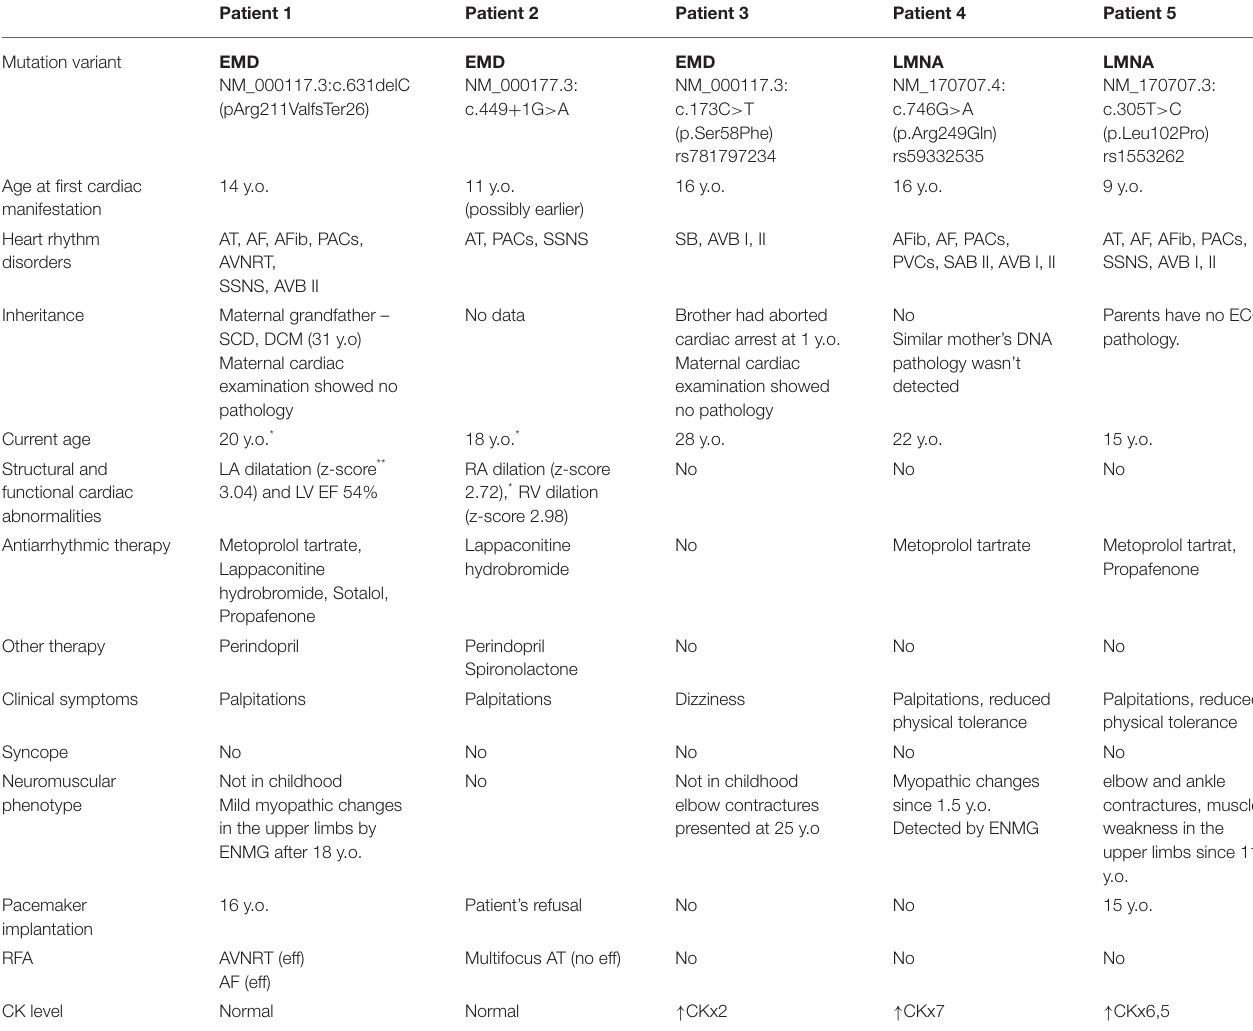
TABLE 1 | Clinical and genetic characteristics of patients affected by EDMD and presented with heart rhythm